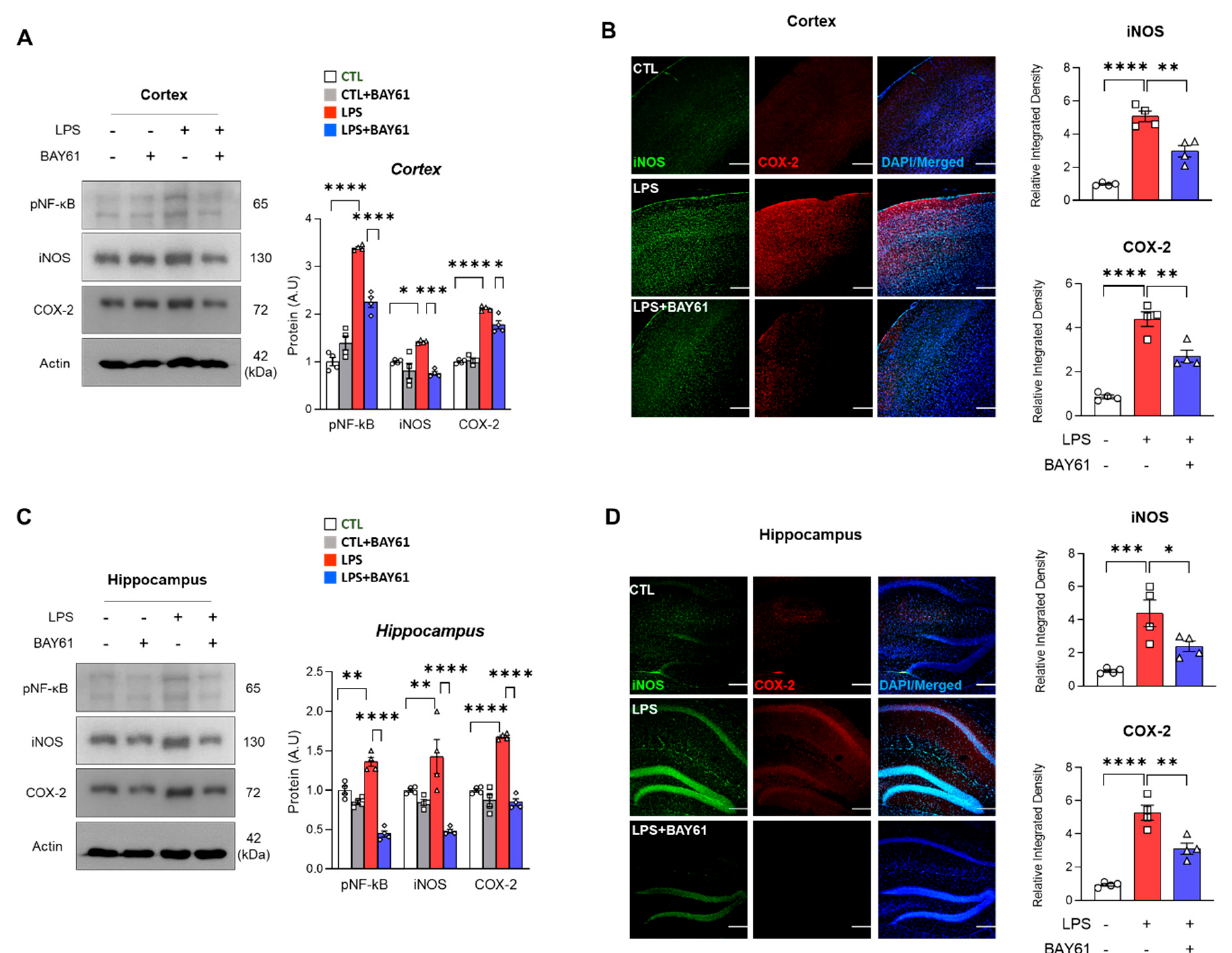
Figure 3. Pharmacological inhibition of Syk mitigates LPS-induced inflammatory mediators in the mice brain. Representative images of ( A ) immunoblot and ( B ) immunofluorescence of inflammatory mediators (p-NF- κ B, iNOS, COX-2) in LPS-treated model with or without BAY61-3606 ( n = 4) in cortex. Representative images of ( C ) immunoblots ( D ) and immunofluorescence of the inflammatory mediators in LPS-treated model with or without BAY61-3606 ( n = 4) in hippocampus. Bar graph color, white: control, grey: control with BAY61-3606, red: LPS, blue: LPS with BAY61-3606. Scale bars, 100 µ m. Values indicate the mean ± SEM. The significant differences have been given in the graphs as follows: * p < 0.05, ** p < 0.005, *** p < 0.0001, **** p < 0.00001 compared with a group of interests and determined by one-way ANOVA followed by Tukey’s multiple comparison test. Abbreviations: Syk, tyrosine-protein kinase; LPS, lipopolysaccharide; p-NF- κ B, phosphor-nuclear factor kappa B; iNOS, inducible nitric oxide synthase; COX-2, cyclooxygenase-2.